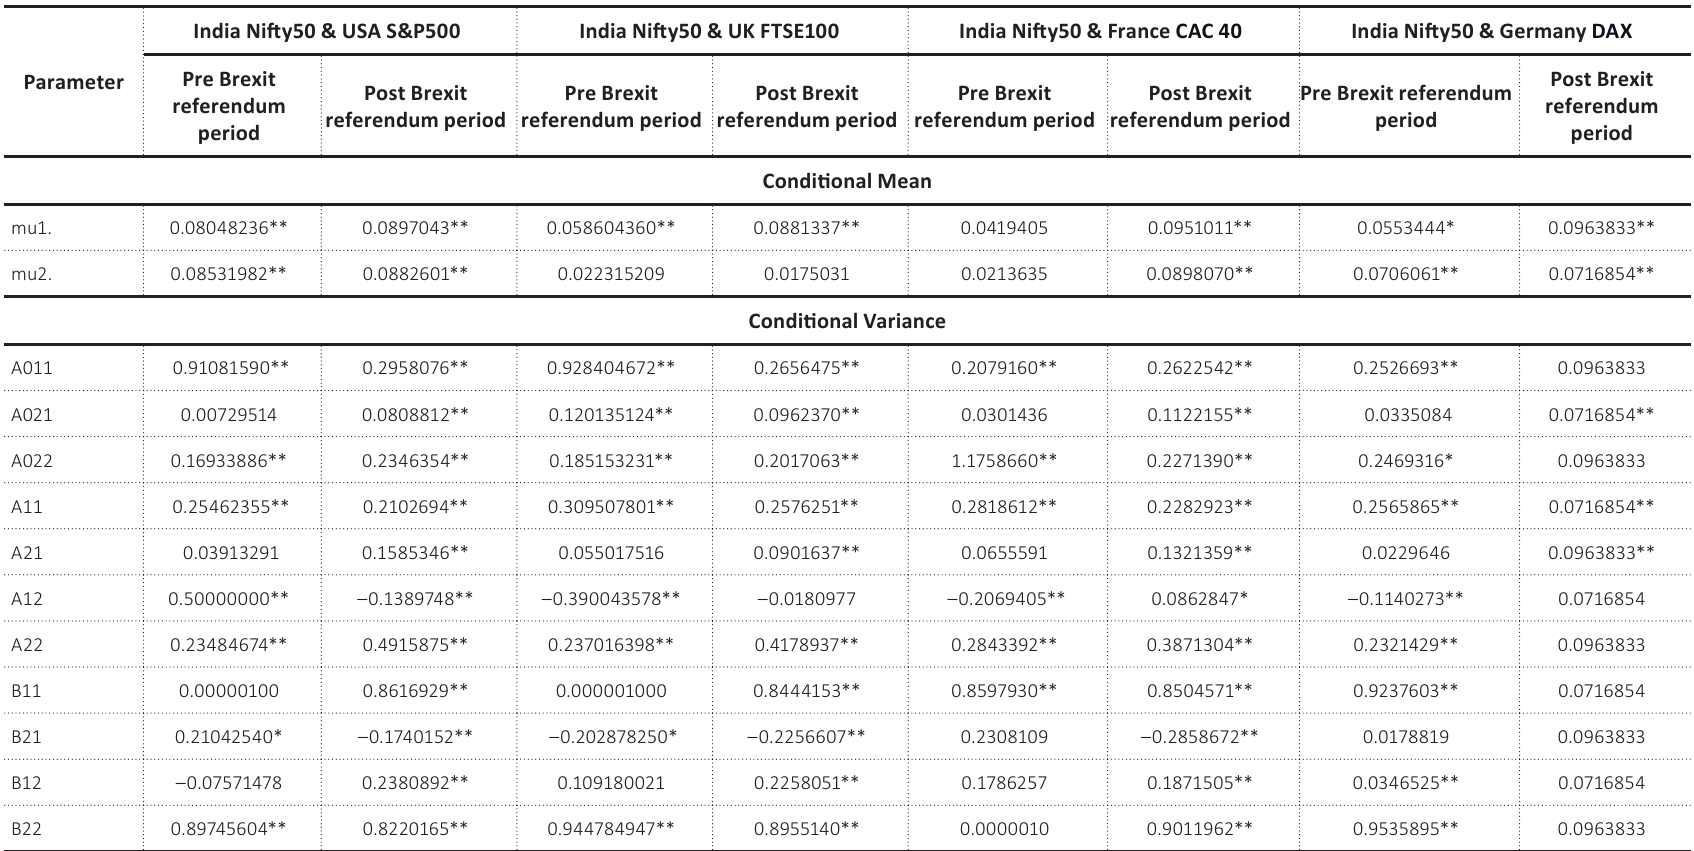
Table 5. Parameter estimates for the bivariate GARCH BEKK model